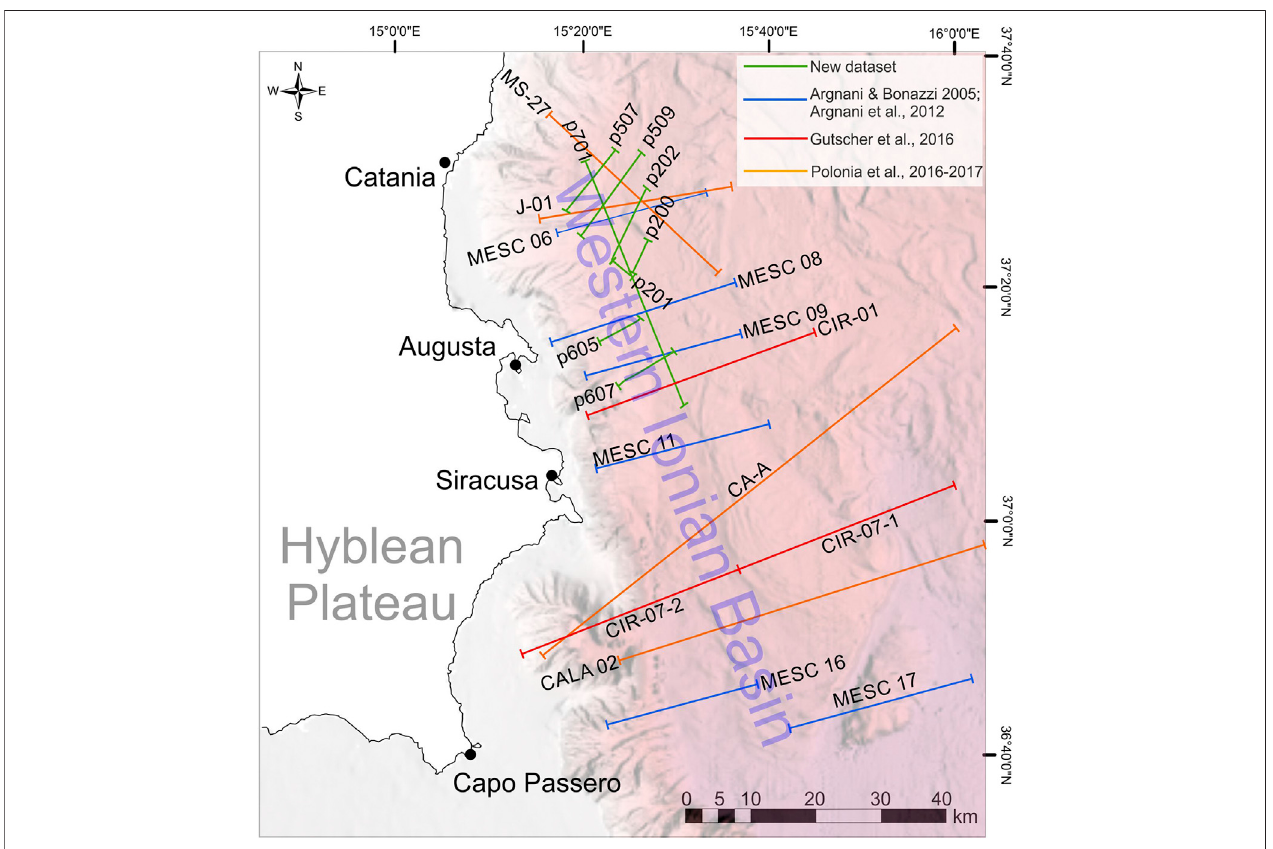
FIGURE2| Location ofthe interpreted seismic dataset inthe offshoreofSE Sicily. The dataset includes new seismic pro fi les (green lines)and previously published geophysical data.